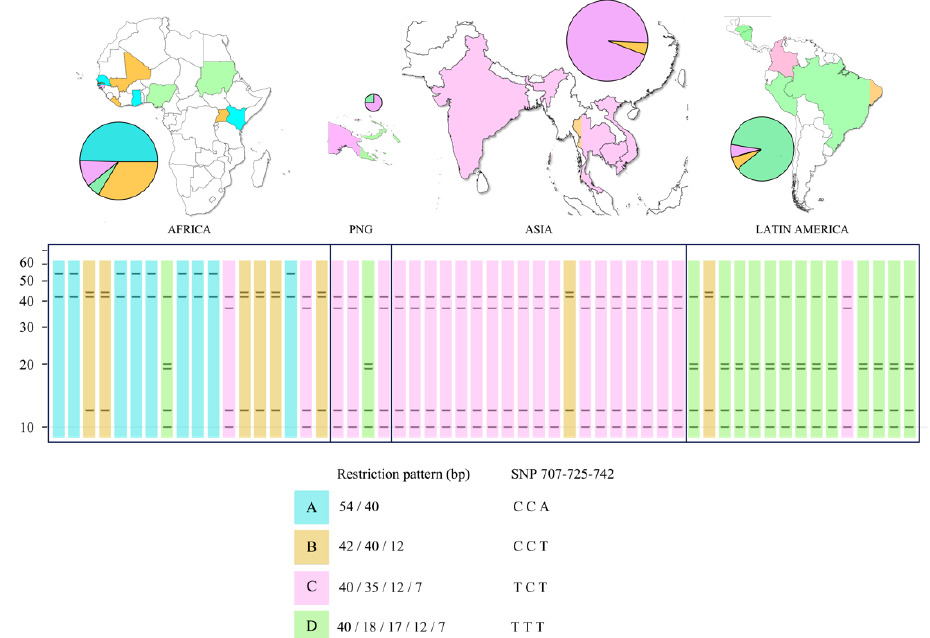
Figure 2. Restriction profiles of the pfs47 gene digested with MseI in relation to the geographic origin of the isolates.